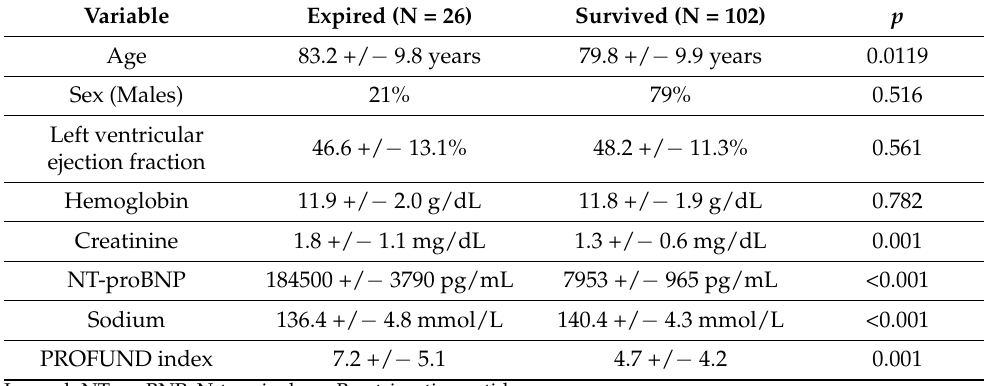
Table 3. Comparative analysis of mortality and survival at 30 days of follow up.